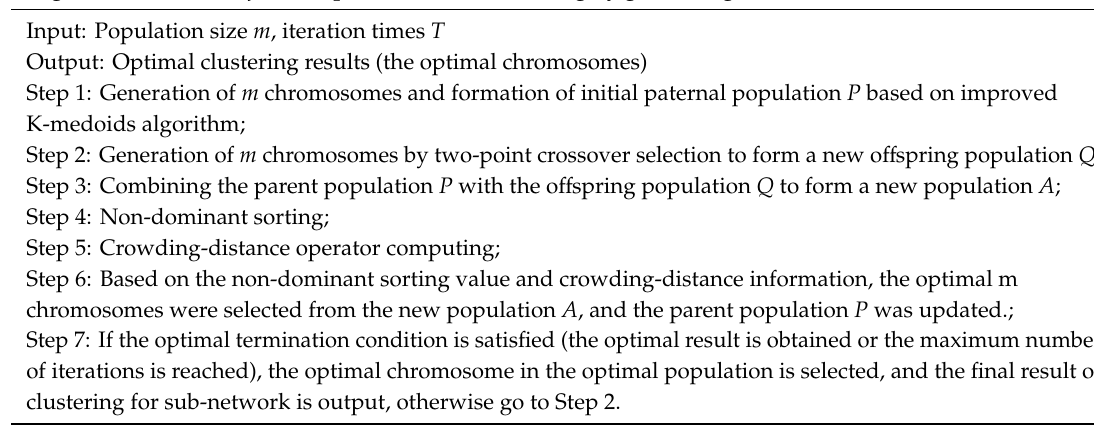
Algorithm 2 Multi-objective optimization of clustering by genetic algorithm